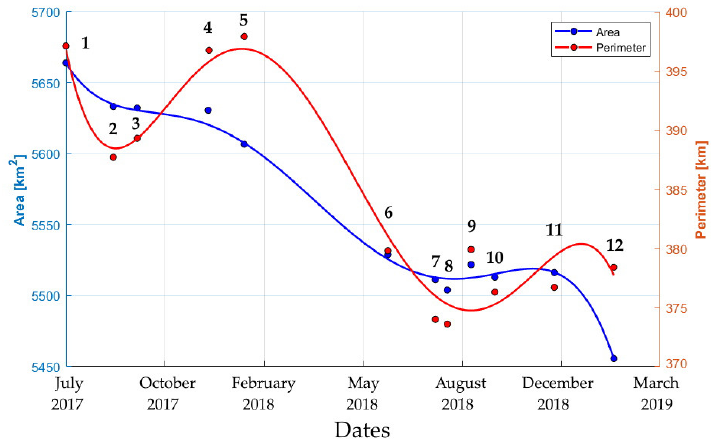
Figure 5. The derived time-series data of the A-68A iceberg. Based on a polynomial least squares regression, the blue and red curves display the long-term tendency of the area and perimeter parameters. The analysis does not take into account the A-68B